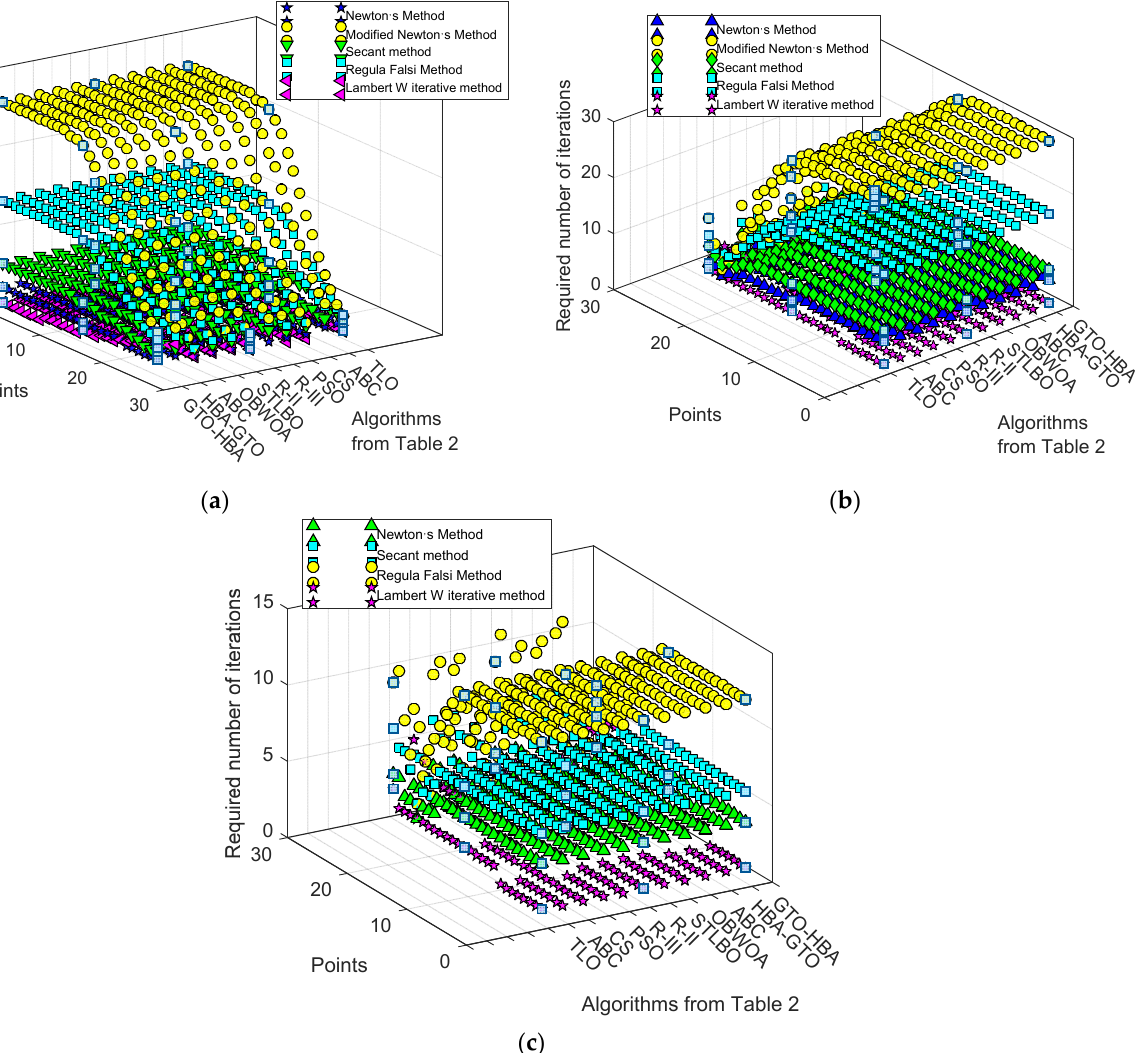
Figure 16. Required number of iterations for all voltage values with 10 − 5 stopping criterion using the five iterative methods: ( a ) x 0 = 1; ( b ) x 0 = 0.7; ( c ) x 0 = 0.5.